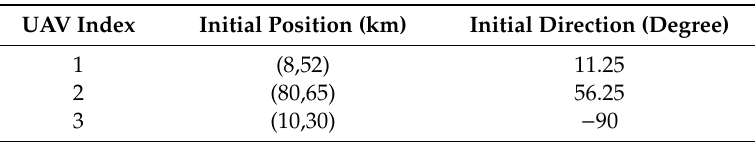
Table 3. Initial settings of the